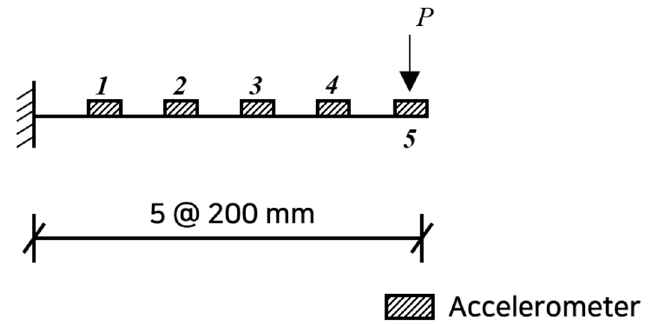
Figure 5. A cantilevered beam subjected to an impulse force at the free end.